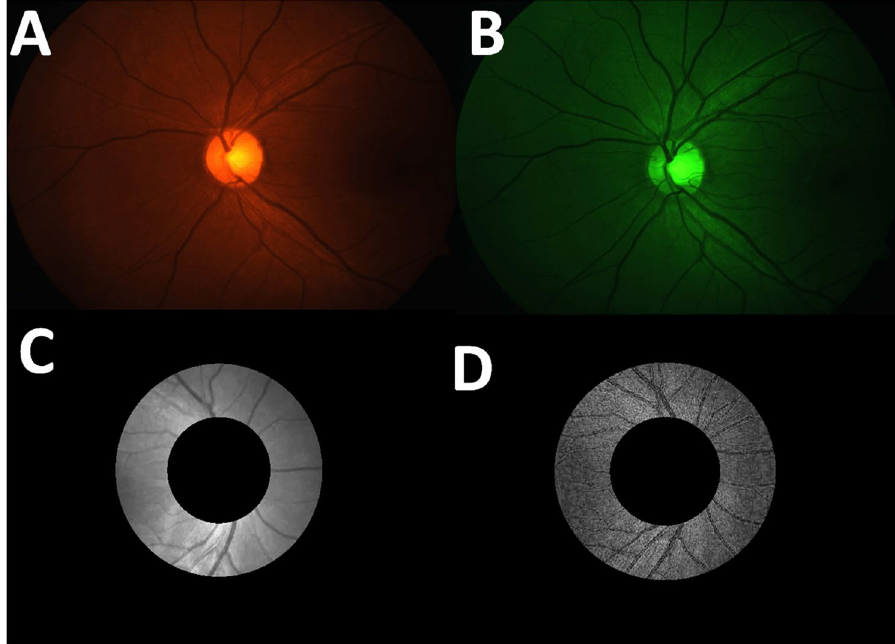
Figure 2. Image Processing Regions from the Captured Fundus Images. ( A ) Image captured with oxyhemoglobin sensitive wavelength. ( B ) Image captured with oxyhemoglobin insensitive wavelength. ( C ) Image processing region of the oxyhemoglobin sensitive wavelength image for the measurement of optical density. ( D ) Image processing region of the registered oxyhemoglobin insensitive wavelength image for the measurement of optical